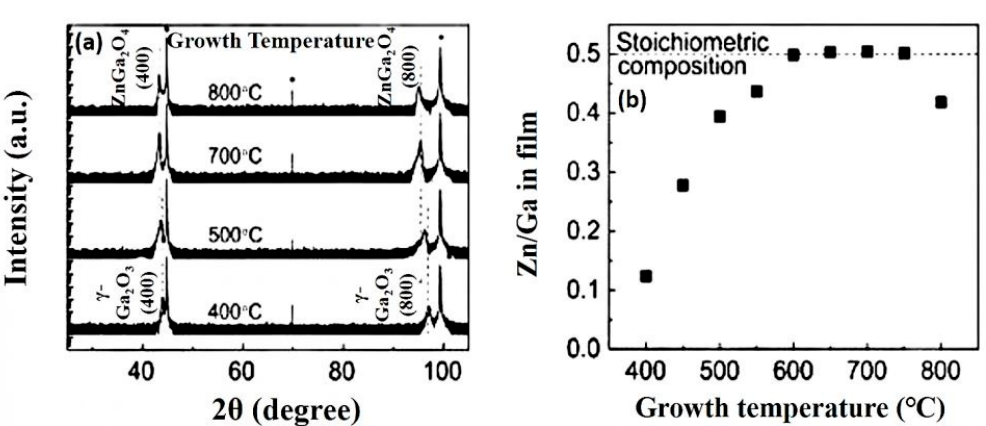
Figure 20. ( a ) Out-of-plane XRD patterns of the films grown at various temperatures using a precursor solution with [Zn]/[Ga] = 1. Asterisks (*) refer to the substrate peaks. Dashed lines indicate peak angles of ZnGa 2 O 4 and γ -Ga 2 O 3 bulks. ( b ) Growth temperature dependence of Zn/Ga in the films as obtained in deposited films [83] (with copyright permission from Elsevier, 2020).